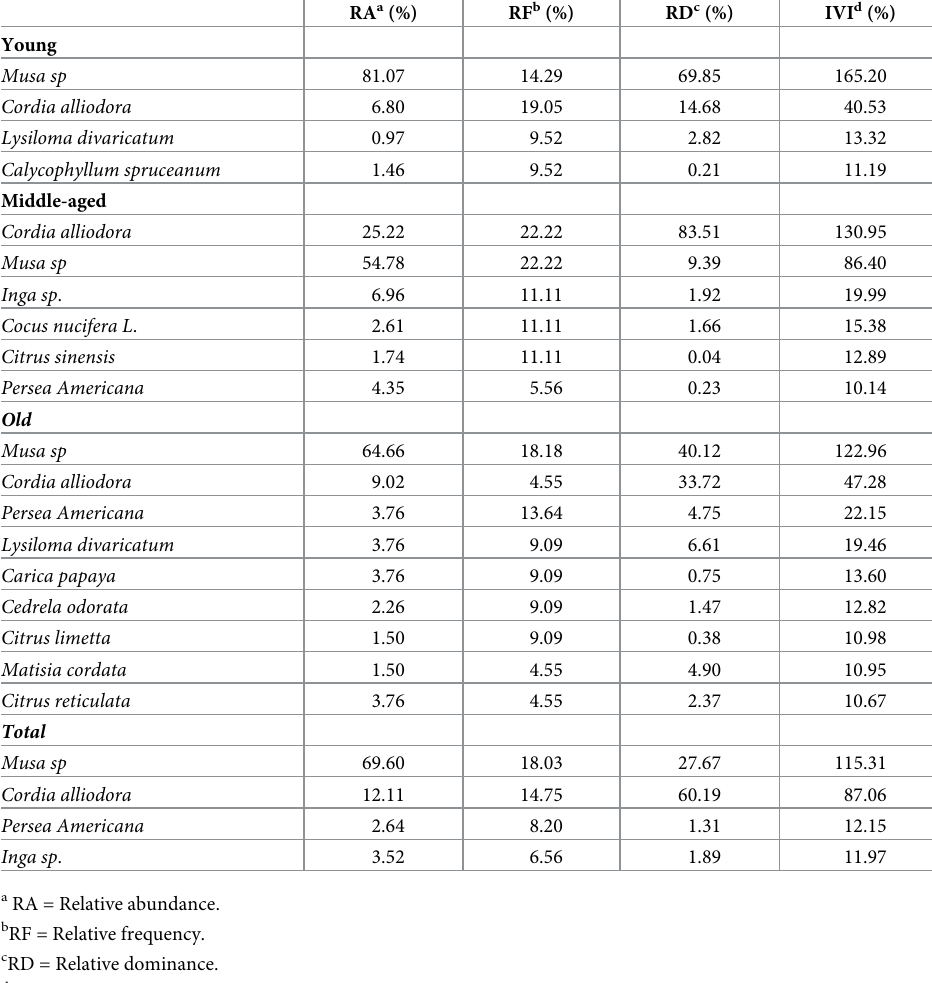
Table 3. Most important species (IVI > 10) by plantation age and